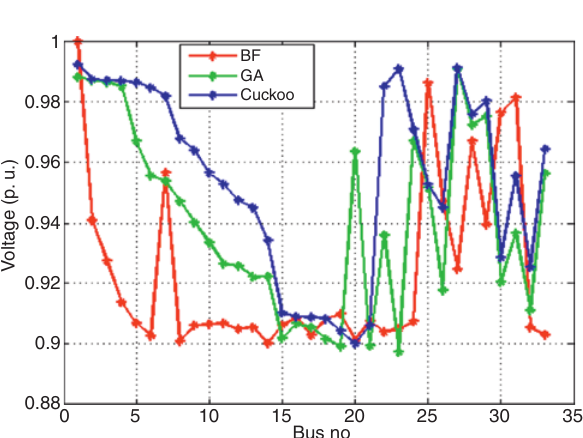
Figure 6: Voltage Comparison between the Proposed Method and the Existing